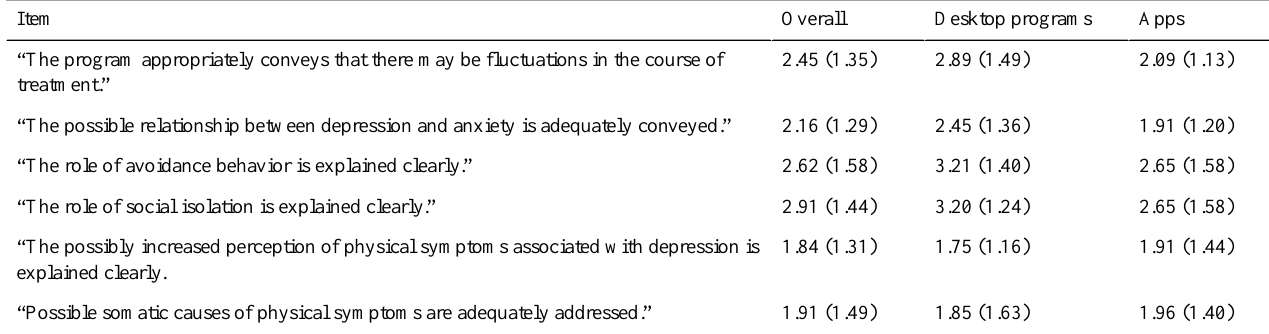
Table 7. Mean (SD) scores for evaluation of psychoeducation features in web-based interventions.